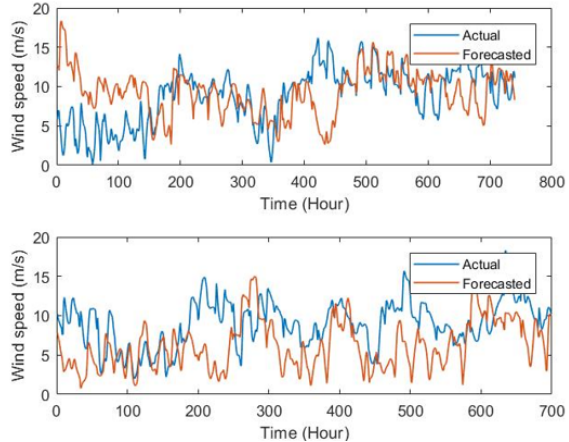
Figure 15. Forecasted and actual wind speeds of 2017, Jun & July, Dhahran, Case II.